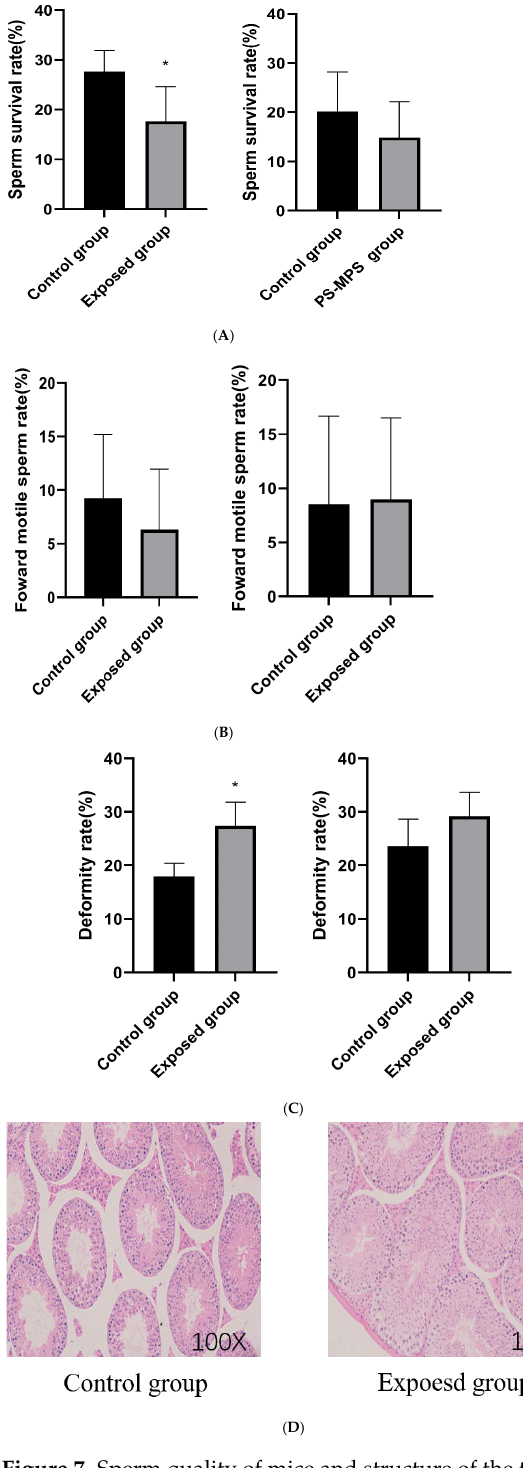
Figure 7. Sperm quality of mice and structure of the testis after recovery period. The left side shows the change after the first recovery time and the right side shows the change after the second recovery time. ( A ) Sperm survival; ( B ) Forward motion; ( C ) Deformity; ( D ) HE staining results of mouse testicular tissue after the first recovery time. The data are expressed as the mean ± SD (n = 8) and analyzed by dependent sample t -test. Note: * p < 0.05 indicates a statistically significant difference from the control. The left side of the figure ( A – C ) shows the results of the first recovery period, and the right side shows the results of the second recovery period.